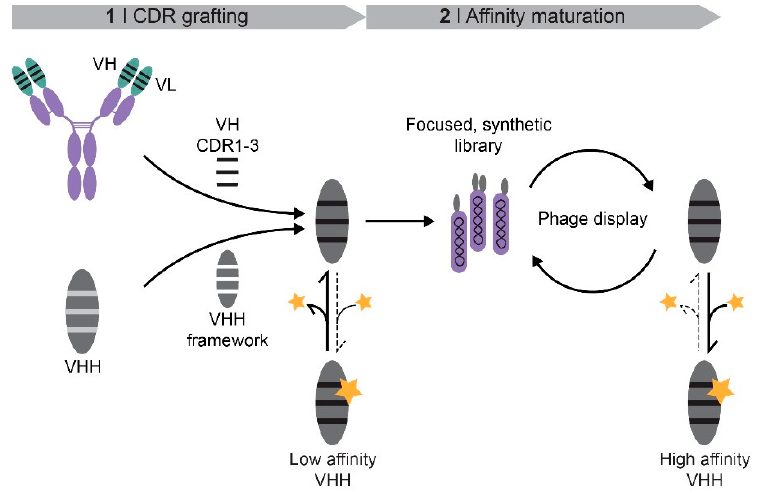
Figure 1. Schematic overview of a two-step approach for the generation of VHH. First, the complementary-determining regions (CDRs) of the heavy-chain variable domain (VH) of a conventional antibody are grafted onto a VHH framework. In a second step, the resulting weak binders, which lack the light-chain variable domain (VL), serve as template for the design of a focused VHH library. The low association rate with the ligand (yellow star) is indicated by the dotted line, the dissociation by the solid line. Affinity maturation is conducted by phage